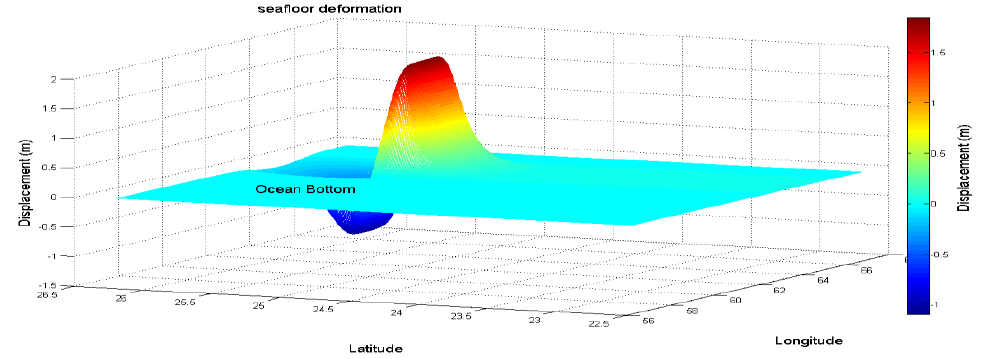
Figure 4. Simulation of three-dimensional sea floor deformation in the earthquake of 1945 MSZ. The amount of maximum uplift is 1.839 m. and max subsidence is 1.099